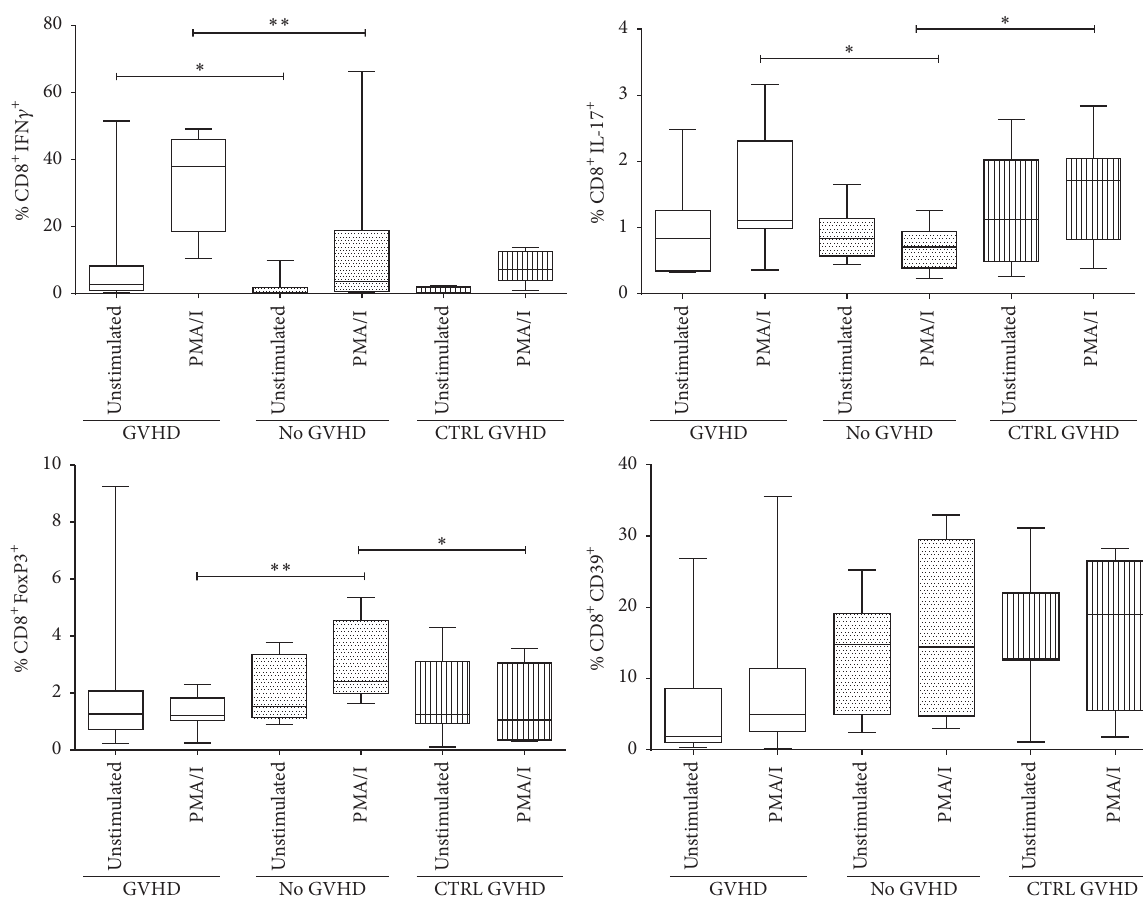
Figure 5: Determination of Tc1, Tc17, and CD8 + Treg in patients without GVHD, with active GVHD, and with controlled GVHD. Patients with active GVHD show an increase in Tc1 and Tc17 cells, while patients without GVHD display an increase in CD8 + FoxP3 + cells compared to patients with active or controlled GVHD. ∗ 𝑝 < 0.05 ; ∗∗ 𝑝 < 0.01